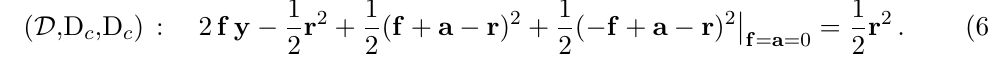
,D c ,D c ) b.c. for D